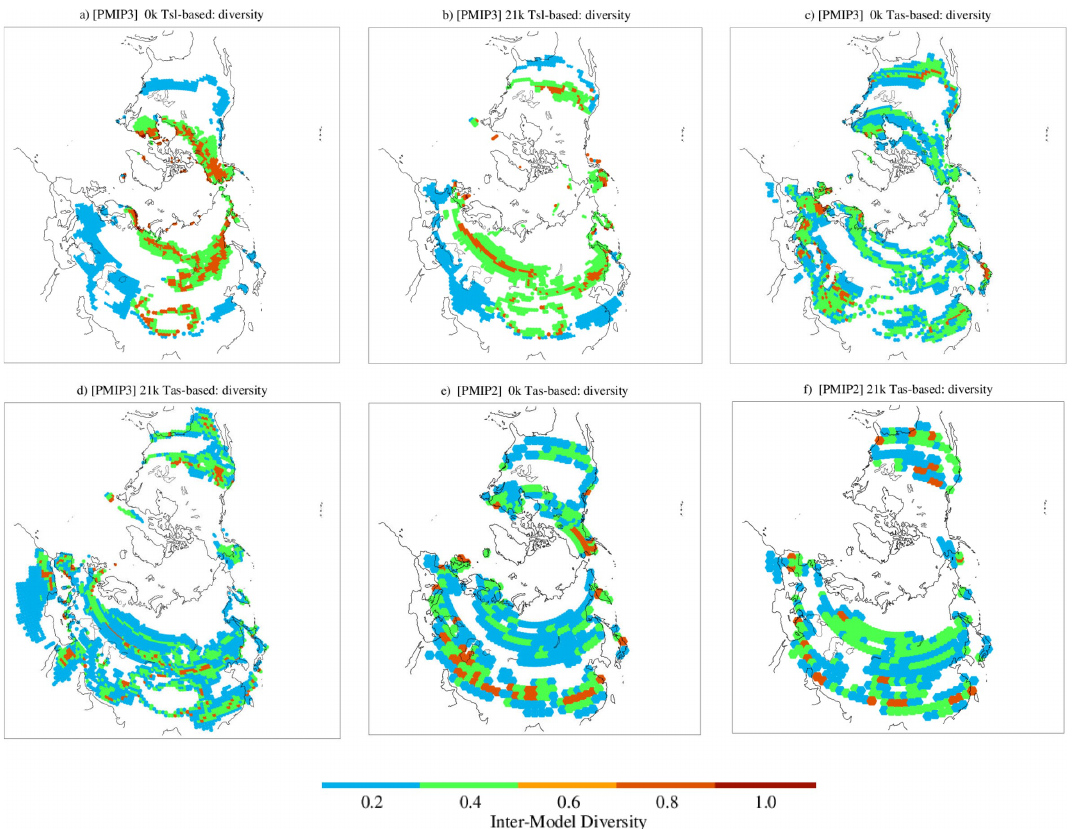
Fig. 3. (a) to (f) same as Fig. 2 except for the inter-model diversity of the diagnosed frozen ground categories. For definition of the diversity index see